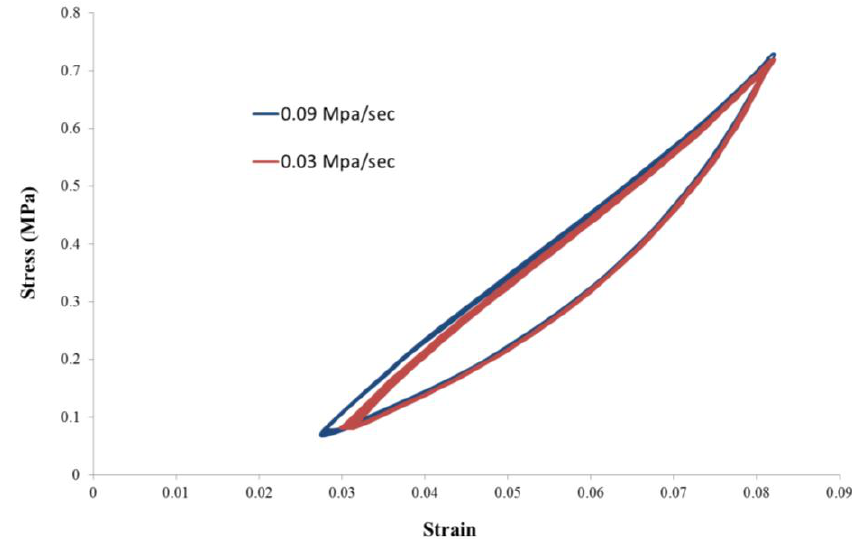
Figure 10. Mechanical testing. Mechanical tests demonstrate that the foam (Deflector f) made in the present study is viscoelastic, and behaves in a virtually identical manner to that of a far smaller foam made using the same recipe.